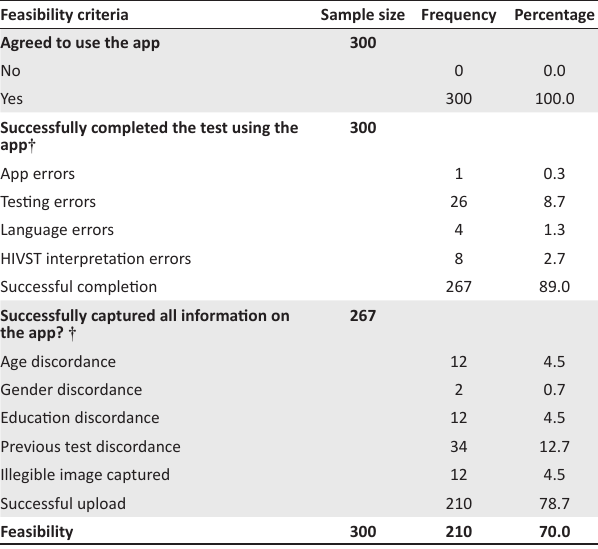
TABLE 4: Feasibility outcomes.